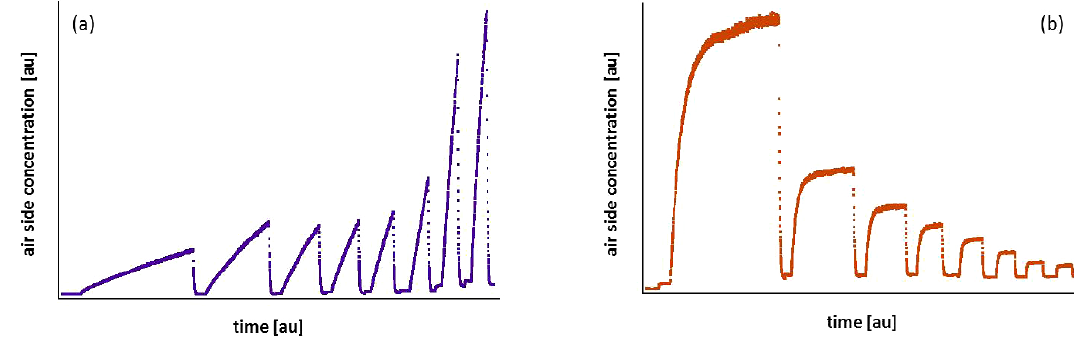
Figure 5. Air-side concentrations obtained for example water-side (a) and air-side (b) controlled tracers throughout the experimental proce-